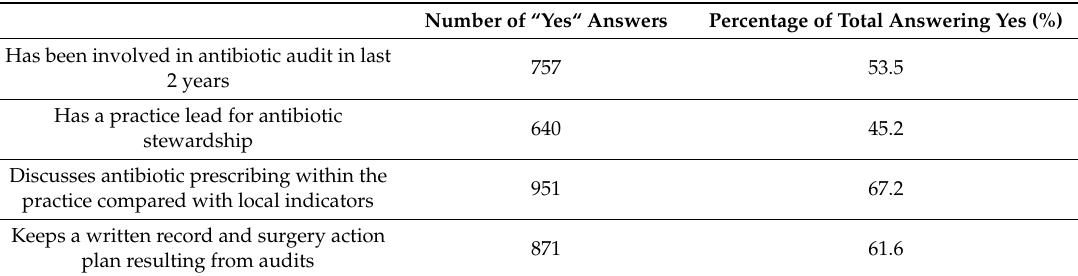
Table 2. Audit and action planning.